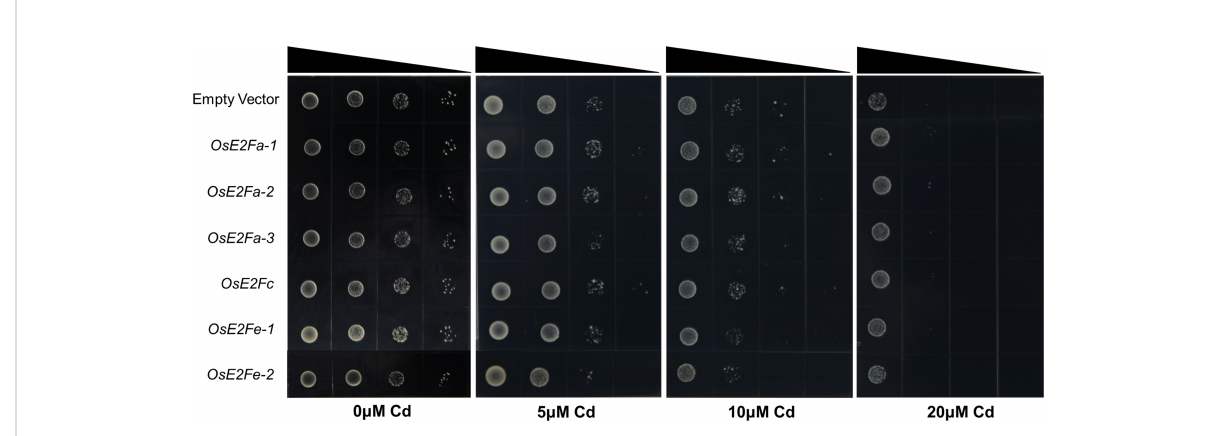
FIGURE 5 Expression of rice E2F members in Cd ion-sensitive mutant strain D ycf1. The empty vector, the control was pYES2, was grown in SD-Ura medium with the PYES2 vector linked with different E2F genes of rice. Induction of different levels of Cd stress was achieved using 0, 5, 10 and 20 m M of